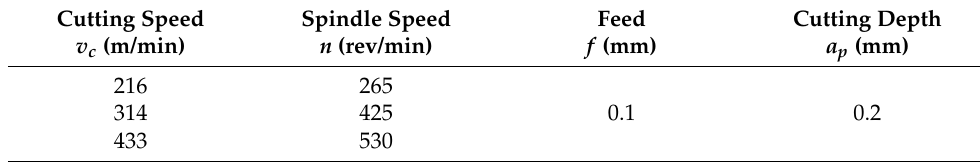
Table 1. Research plan of grey cast-iron